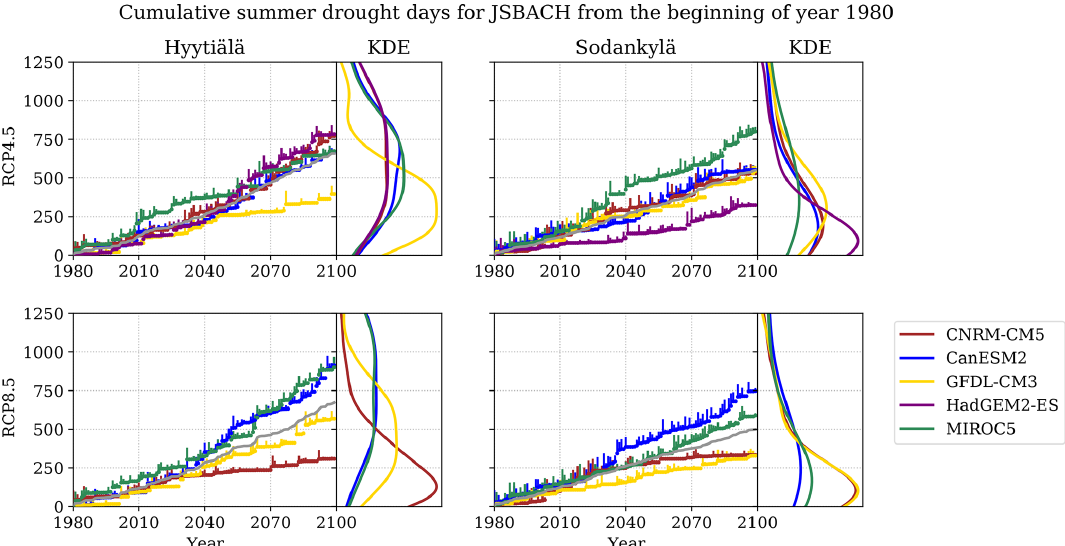
Figure 8. Accumulated summer drought days scatter plotted for each climate model, averaged over model parameterisations with minimum and maximum increment visualised as y -axis whiskers. The grey line is the average of the simulations. The KDE estimates on the right side depict the distribution of the accumulated drought days with the different parameterisations at the end of the simulation. The KDE figures have been cut at 1250 accumulated